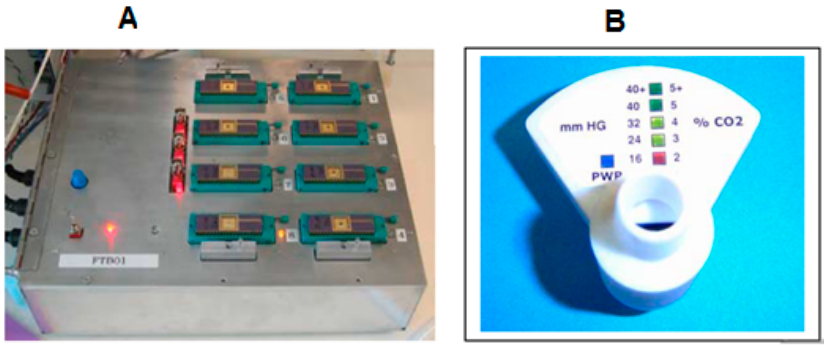
Figure 11. ( A ) Functional test board (FTB) loaded with eight packaged die containing functionalized NTFET devices. ( B ) Mockup capnography device. Reproduced with permission from reference [28].